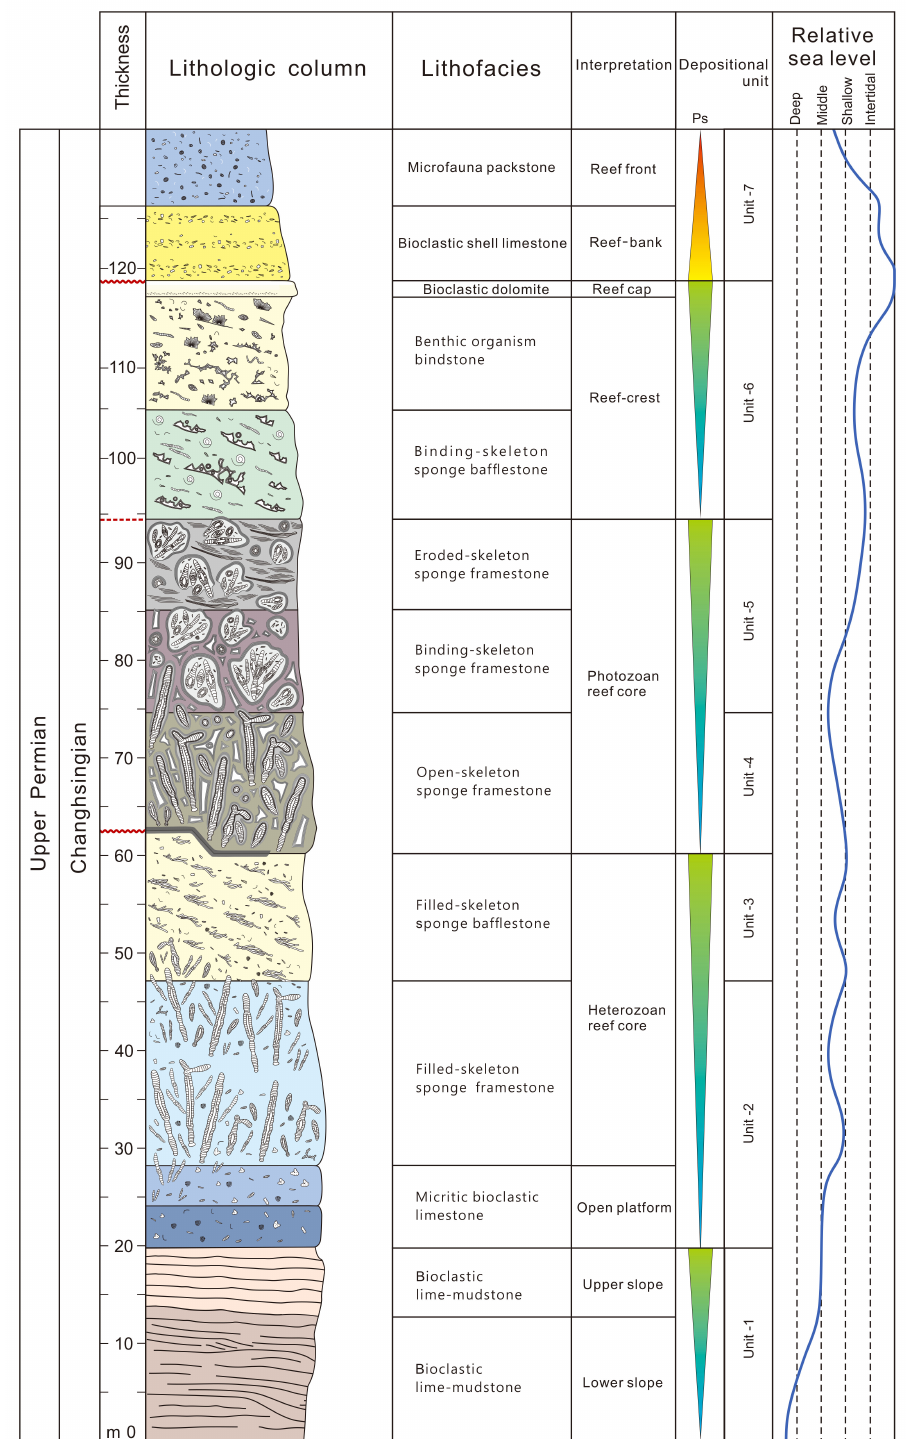
Figure 2. Vertical distribution of lithofacies in the measured stratigraphic and sedimentological columnar sections of the Jiantianba reef. The sedimentary log is from the central part of the outcrop, and the detailed location has marked at Figure 3A. Five parasequences have been identified; the lower four parasequences show the features as upward shallowing cycles. The relative sea level change curve represents the different tendency of the water-depth change in each lithologic section, and the precise explanation has placed in the Section